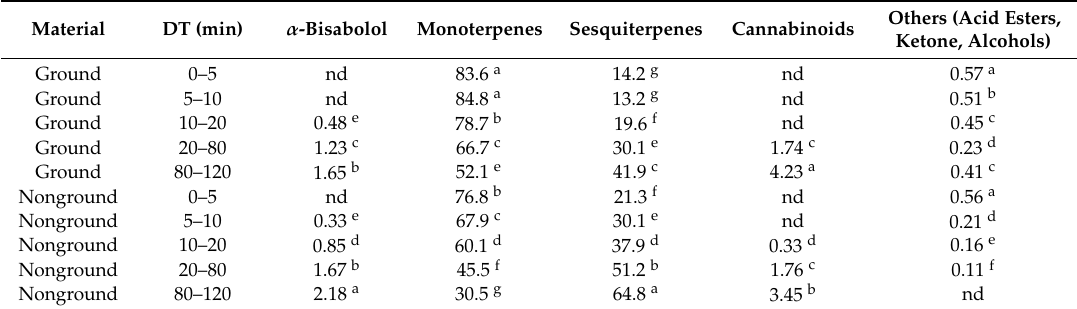
Table 5. Mean α -bisabolol, monoterpenes, sesquiterpenes, cannabinoids, and others (acid esters, ketone, alkochol) obtained from the 10 combinations of Material and Distillation time